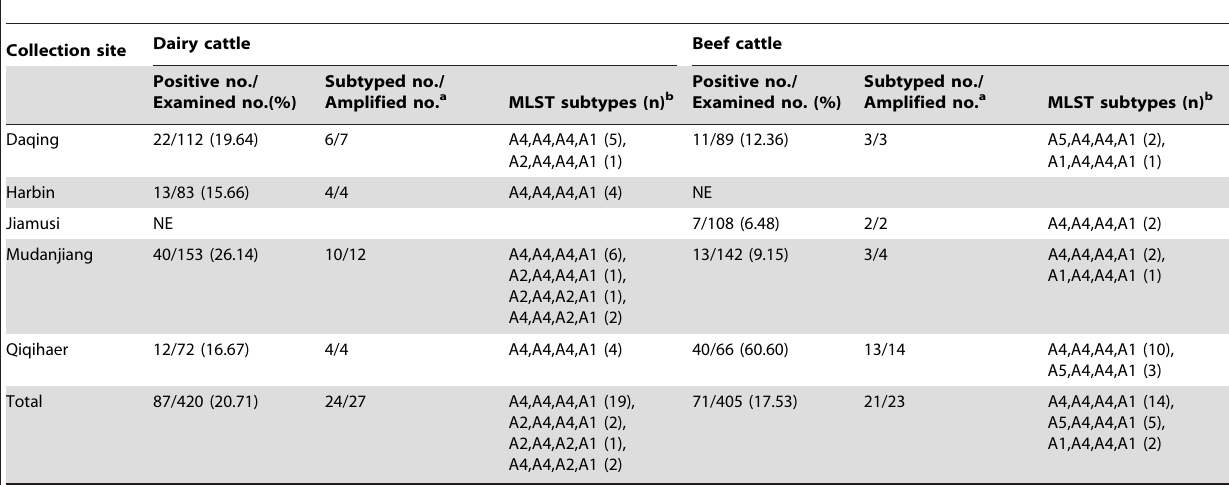
Table 2. Prevalence and MLST subtypes of C. andersoni from dairy cattle and beef cattle.